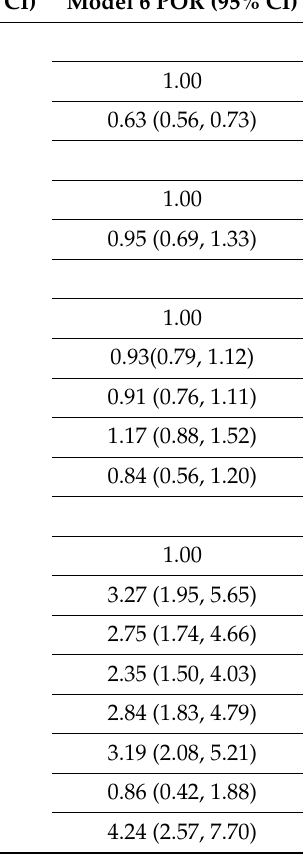
Table 4. Unadjusted and adjusted posterior odds ratios (POR) and associated 95% credible regions of circumcision of girls, ages 0–14, across selected covariates (pooled 2010 to 2017 SDHS) from Bayesian geo-additive models.